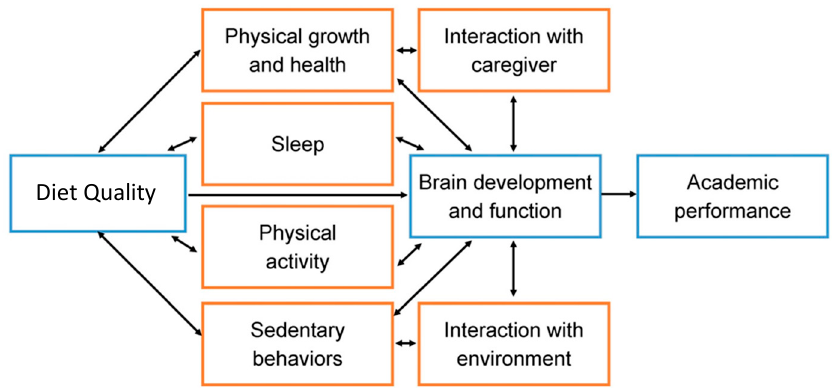
Figure 1. Hypothetical and simplified model on the direct and indirect effects of nutritional status and diet on brain development and academic performance in children (adapted from Reference [36]).